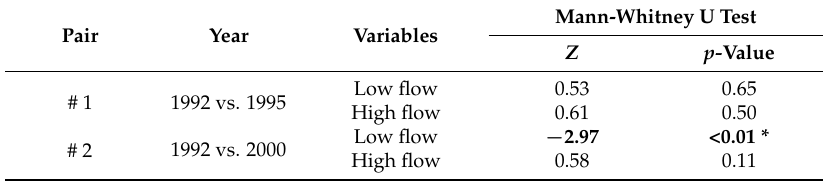
Figure 10. Comparison on the magnitude of low flows and high flows in selected pairs: ( a ) 1992 vs. 1995; and ( b ) 1992 vs. 2000.